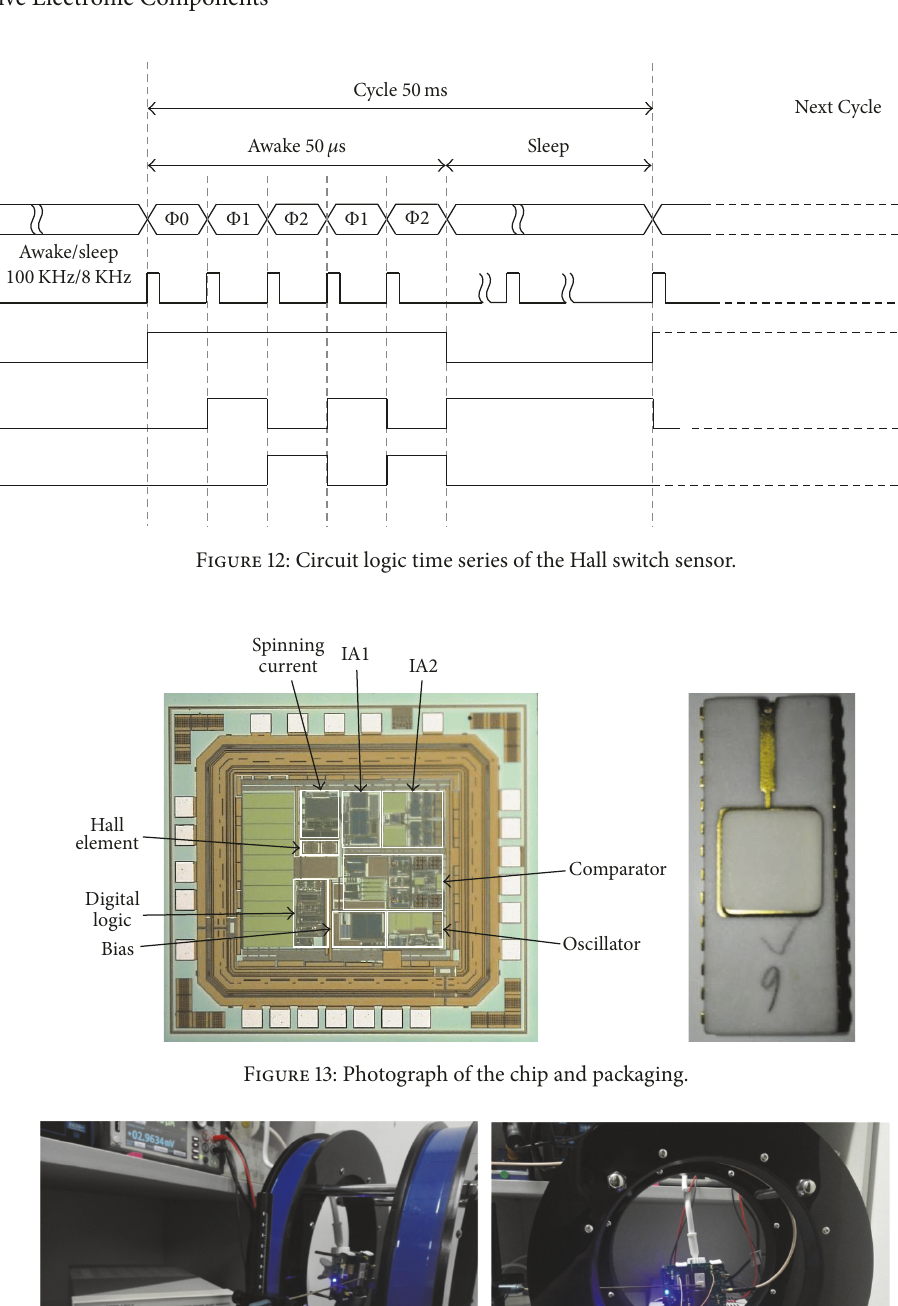
Figure 13. The design area of the chip was 720 𝜇 m × 550 𝜇 m. A dual in-line 28-pin ceramic package (CDIP28L) was